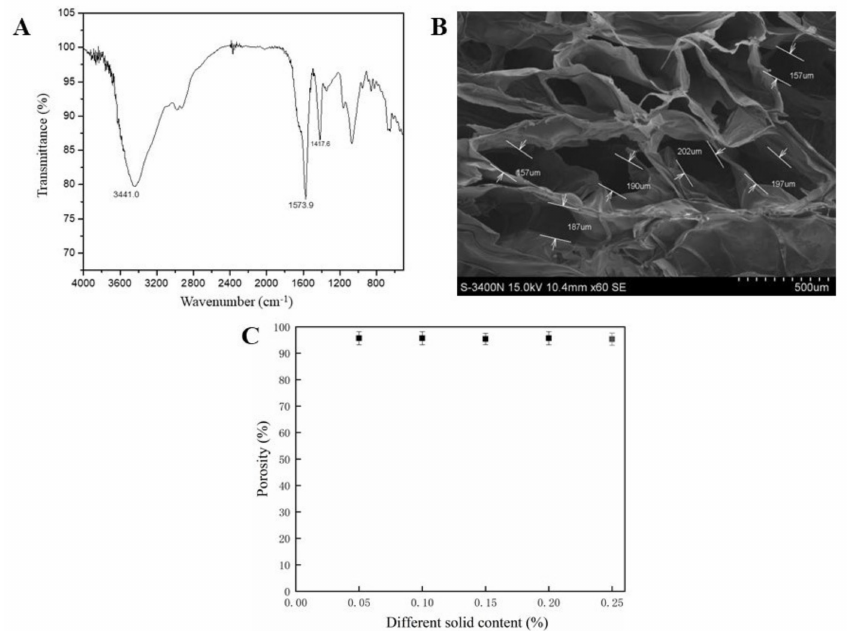
Figure 1. FTIR spectrum ( A ), SEM image ( B ), and Porosity ( C ) of Alg/HA/ICol scaffold.